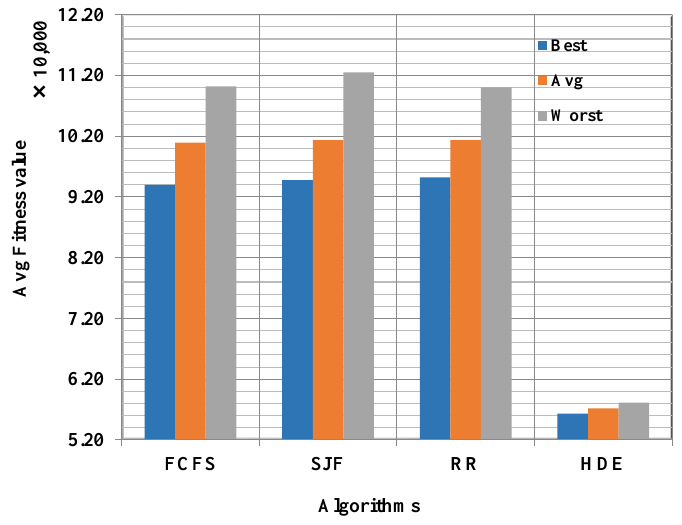
Figure 13. Comparison among algorithms for makespan.